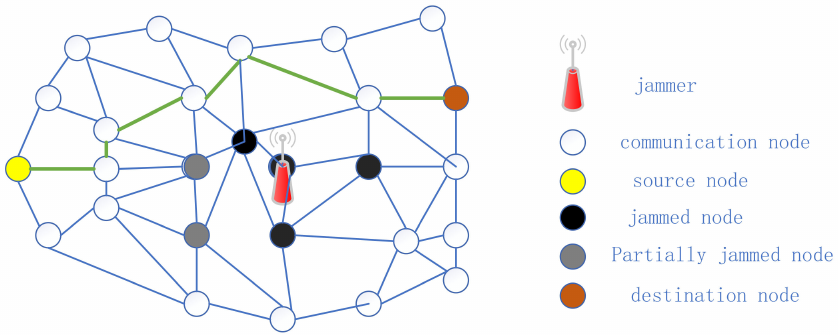
Figure 4. Schematic diagram of communication